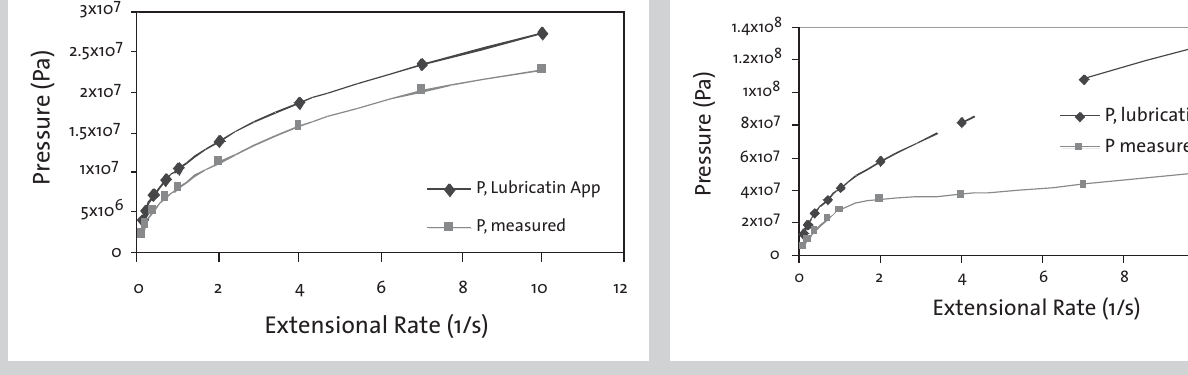
Figure 9 (left above): Pressure versus extension rate for NPE952 at a strain of 7: calculated by means of the lubrication approxima- tion and measured. Figure 10 (right above): Pressure drop versus exten- sion rate for NTX101 at a strain of 7: calculated by means of the lubrication approximation and mea- sured. Figure 11: Melt fracture flow curve for NTX101 obtained at T=150 ∞ C. g · denotes the onset of smf surface melt fracture, g · ssf denotes the onset of slip- stick fracture, and g · gmf denotes the onset of gross melt fracture (I: stable flow regime, II: surface melt frac- ture regime, III: slip-stick fracture regime, IV: gross melt fracture